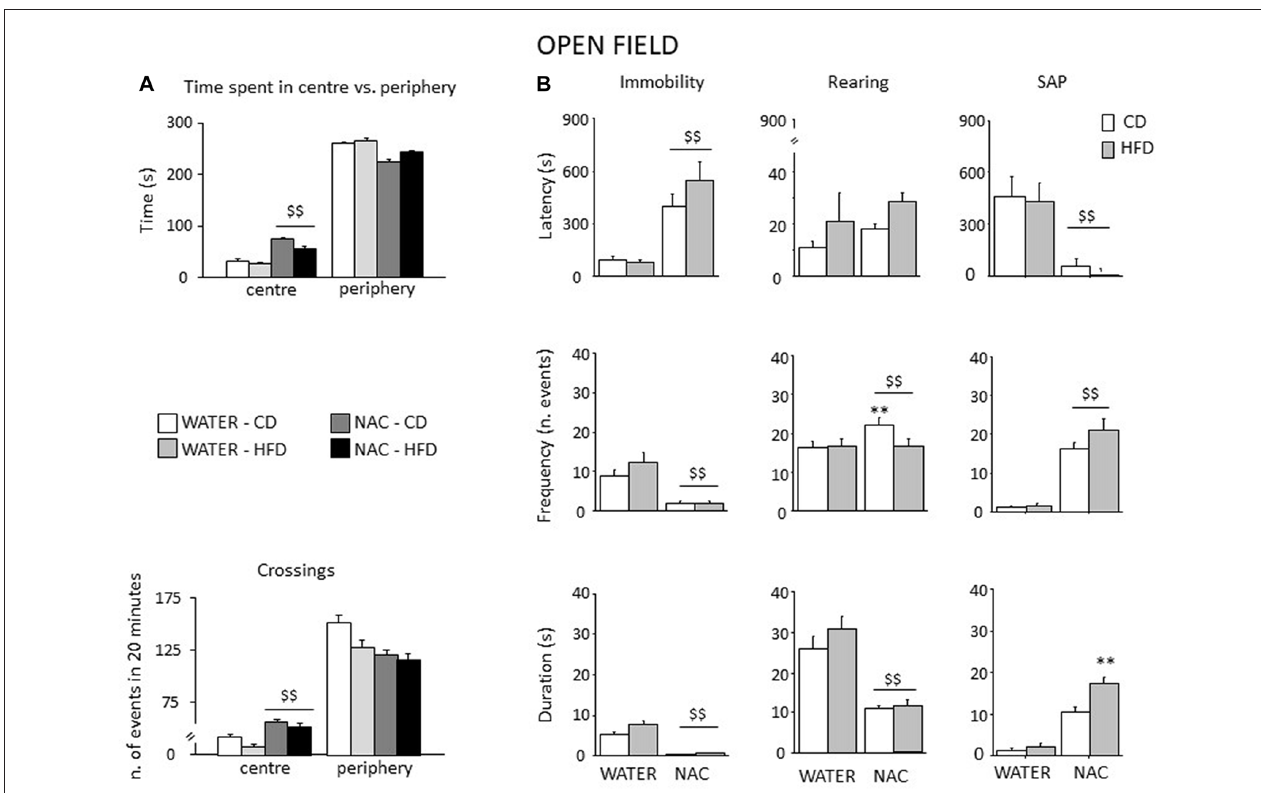
FIGURE 7 | Spontaneous behavior in the OF test. In general, NAC led to a reduced emotionality and increased exploration in the OF test (A) . NAC-treated subject spent more time and were characterized by increased locomotion in the central part of the arena when compared to controls. In the plus-maze test, NAC mice showed an increased latency and a reduced frequency and duration of immobility (B) . NAC increased rearing bouts, particularly in CD subjects while decreasing the overall duration of this behavior (B) . In addition, the latency to the first risk-assessment episode (stretched-attend posture—SAP) was strongly reduced in NAC-treated mice while the frequency was increased; the combination of prenatal NAC and HFD increased the duration of the stretched-attend-posture behavior (B) . Data are mean + SEM $$ p < 0.01, NAC vs. WATER; ∗∗ p < 0.01; NAC-CD vs.